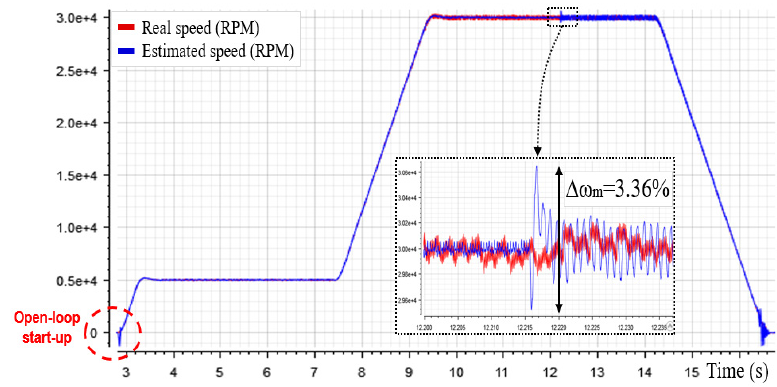
Figure 19. Waveforms of rotor real and estimated speed.